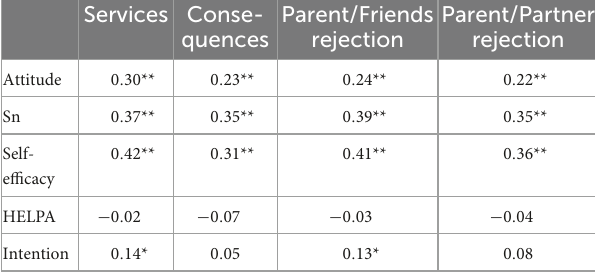
TABLE 10 Correlations of Pearson IH-RHAC scales with resource subscales. Services Conse- Parent/Friends Parent/Partner quences rejection